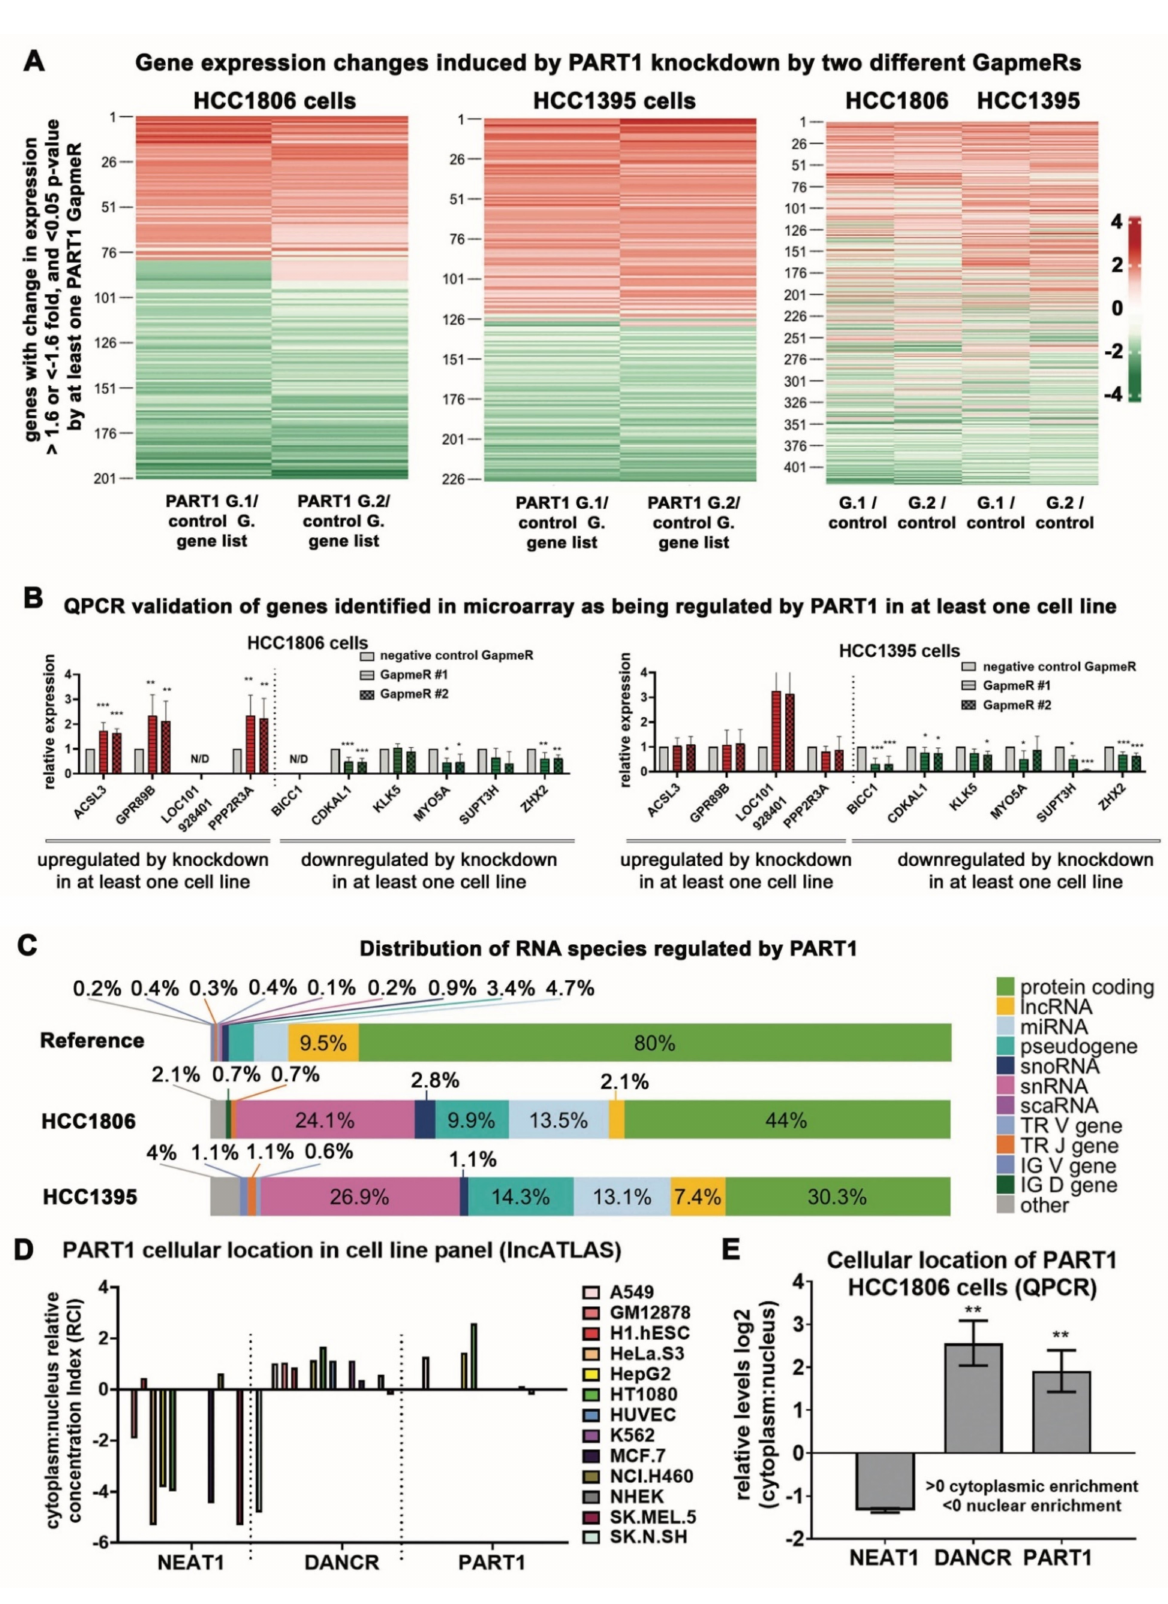
Figure 4. PART1 induces gene expression changes in HCC1806 and HCC1395 TNBC cells and is cytoplasmic. ( A ) Transcrip- tome changes induced by PART1 knockdown (Gapmer1 (G.1) or Gapmer2 (G.2) versus control GapmeR (control G.) were quantified in HCC1806 and HCC1395 cells using the Affymetrix Human Gene 2.0 ST microarray platform ( n = 3).